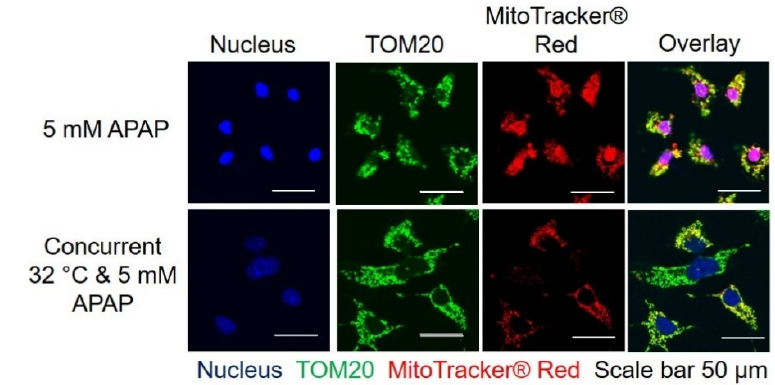
Figure 3. Effect of moderate hypothermia (32 °C) on concomitant mitophagy and mitochondrial biogenesis in the presence of 5 mM APAP-induced hepatocellular injury (AIHI) in TAMH. Immunofluorescence imaging was performed with MitoTracker ® Red and TOM20 to track the initial and total number of mitochondria, respectively, prior to and after APAP treatment and hypothermia. Scale bar = 50 µm.